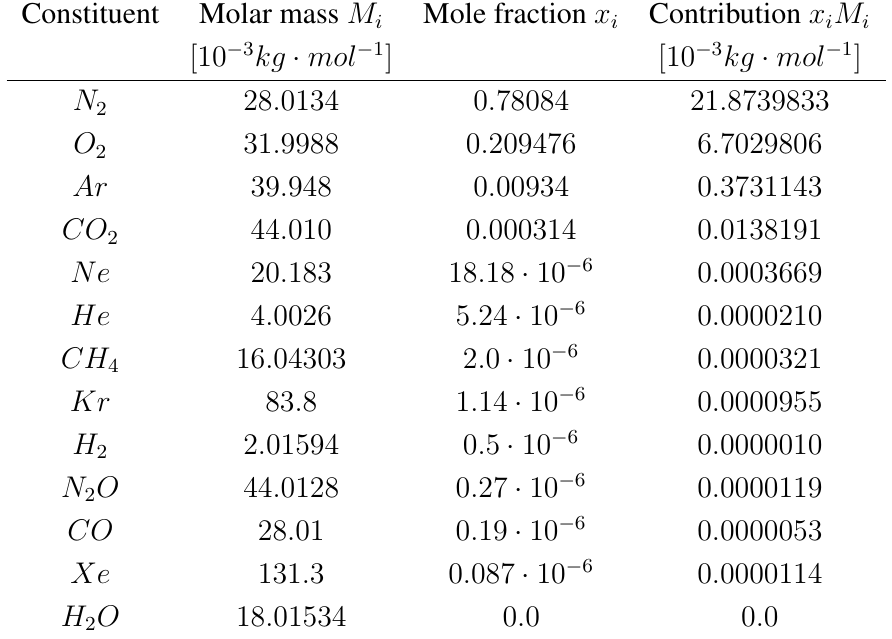
Table 1. Constituents of standard dry air.